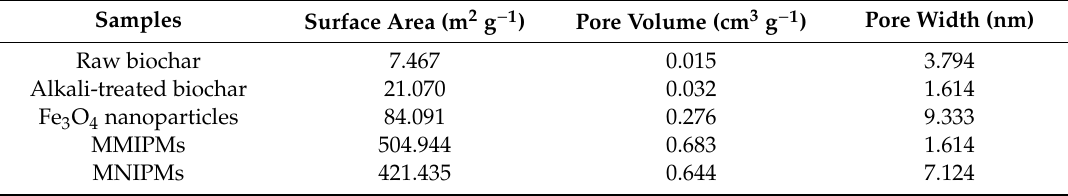
Figure 3. Brunner-Emmet-Teller (BET) measurements, N 2 adsorption-desorption isotherms of raw biochar, alkali-treated biochar, Fe 3 O 4 nanoparticles, MMIPMs and MNIPMs ( a ). Pore size distribution of MMIPMs, MNIPMs and alkali-treated biochar ( b ). Table 1. The surface area, pore volume, and pore width of raw materials and biochar composites materials.